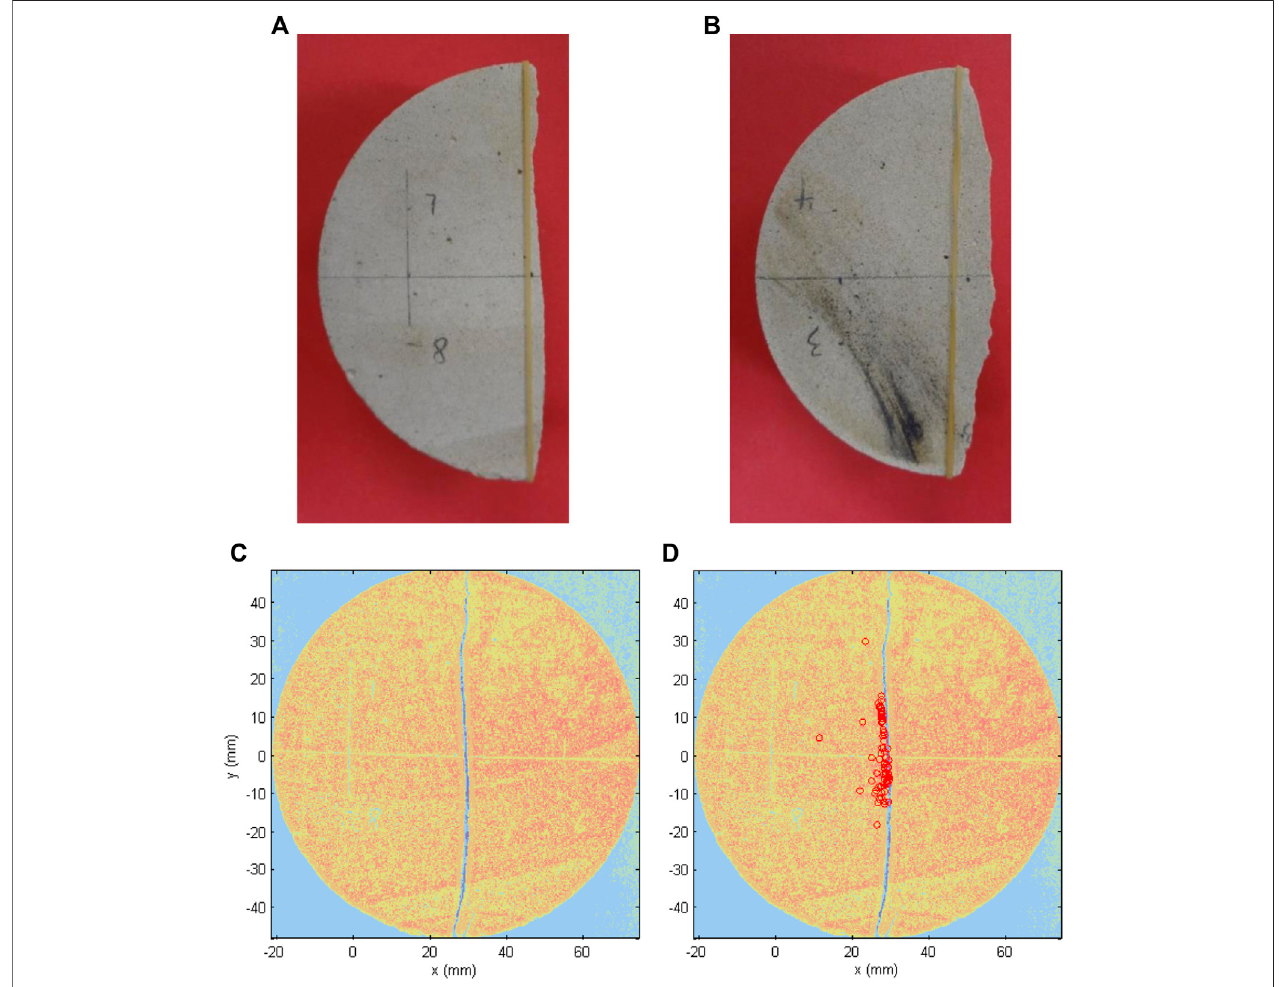
FIGURE 5 | (A) Top view of the left half disc, (B) bottom view of the left half disc, (C) grey scale intensity photo of the specimen after failure (C) and (D) grey scale intensity photo of the failed specimen photo superimposed with AE source locations (red circles) . In (C) and (D) the blue color represents air and yellow-red color suggests the sample